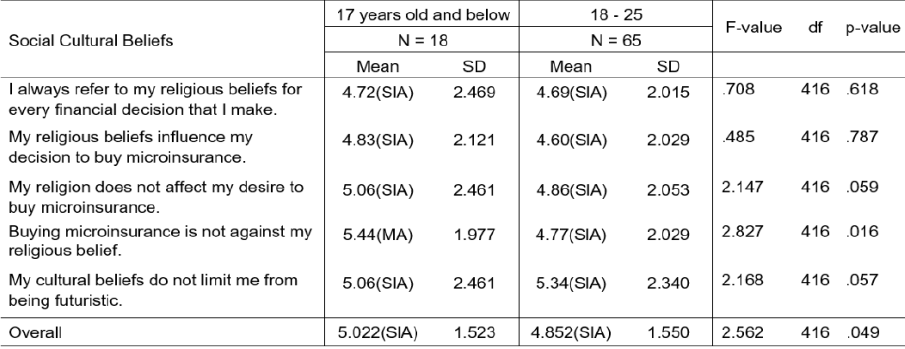
Table 2: Level of Agreement of the Respondents on the Social Cultural Beliefs on Microinsurance According to